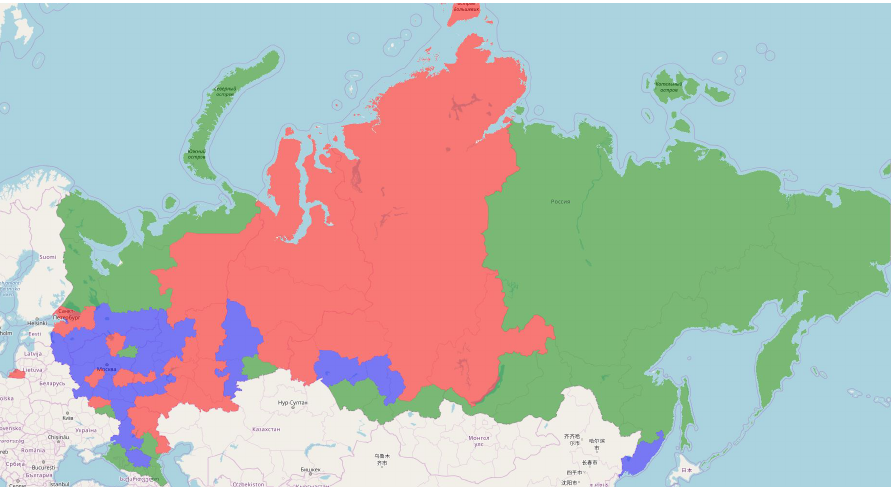
Figure 2. Regions of Russia, clustering by specialization,